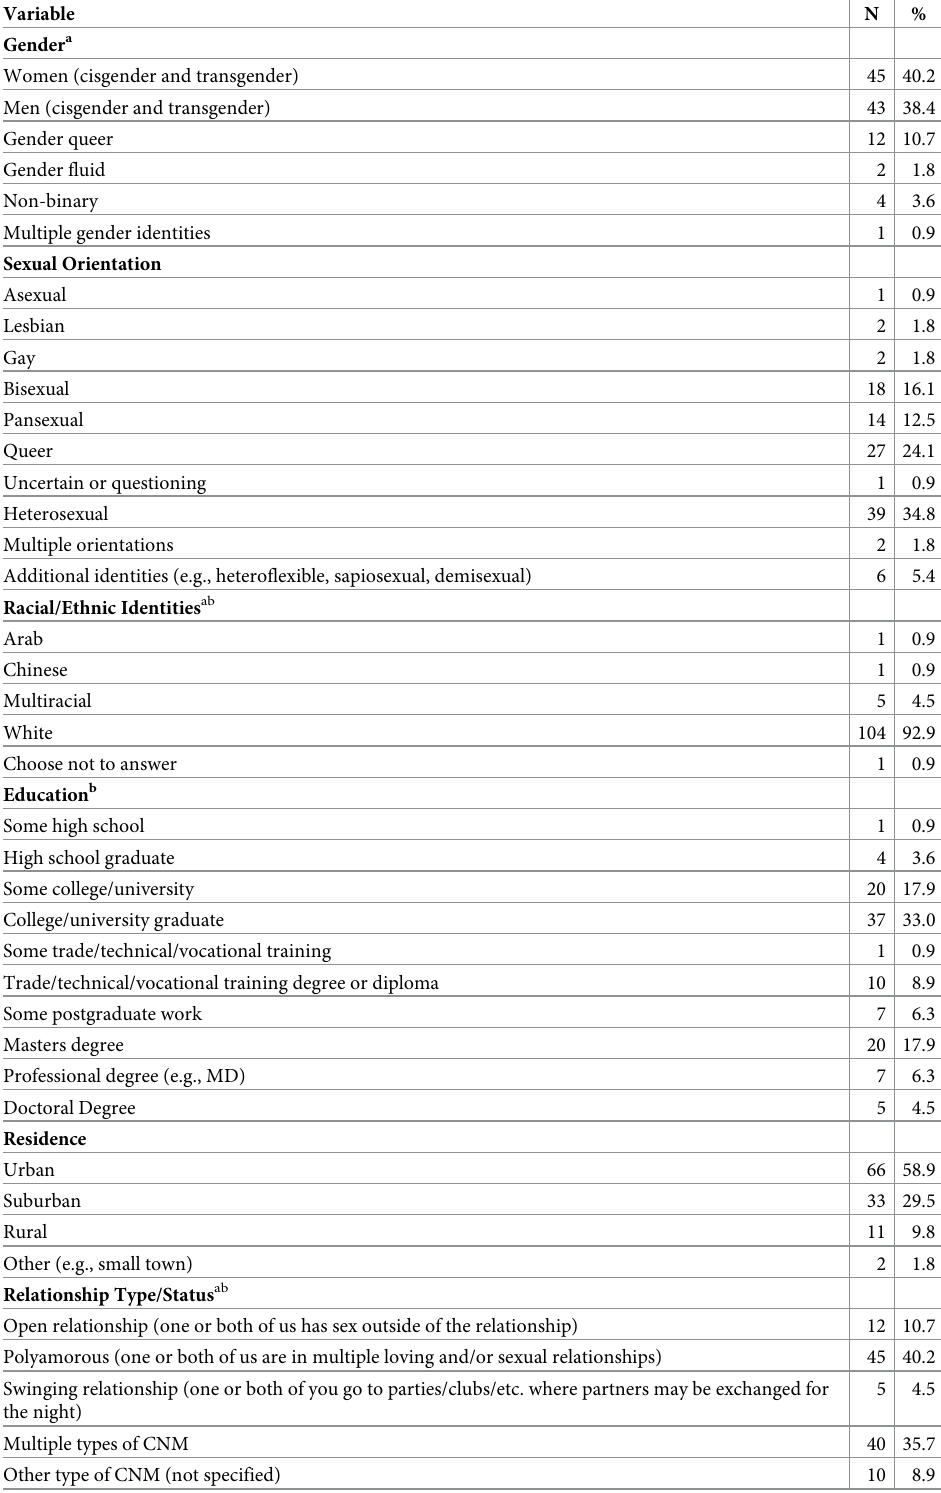
Table 1. Demographic